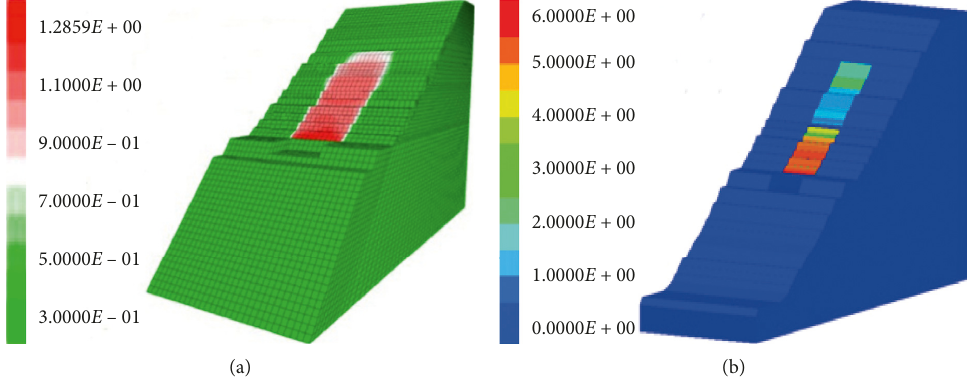
Figure 32: Comparison of displacement distribution contour after the landslide instability